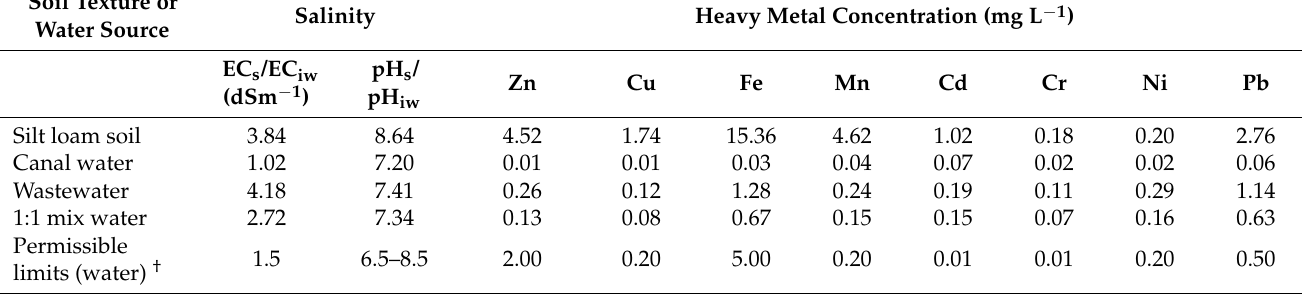
Table 1. Textural class of soil and, salinity and heavy metal concentrations of the soil and irrigation waters used in the